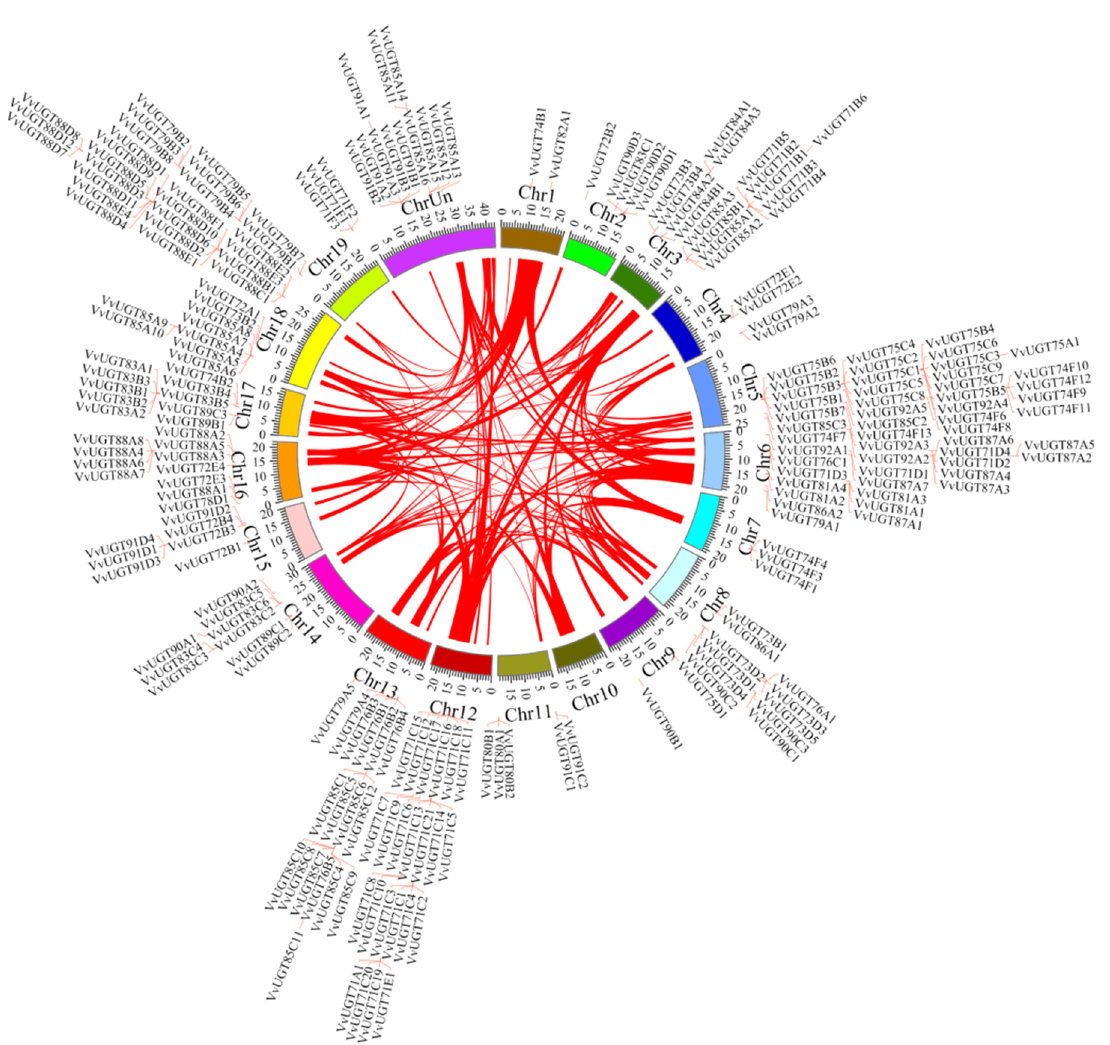
Figure 2. Chromosomal distribution and duplication analysis of UGT genes in grapes. UGT genes were mapped into different chromosomes in grapes. The chromosome number is indicated on the outside. Red lines connecting two chromosomal regions indicate duplicated regions among grape chromosomes.